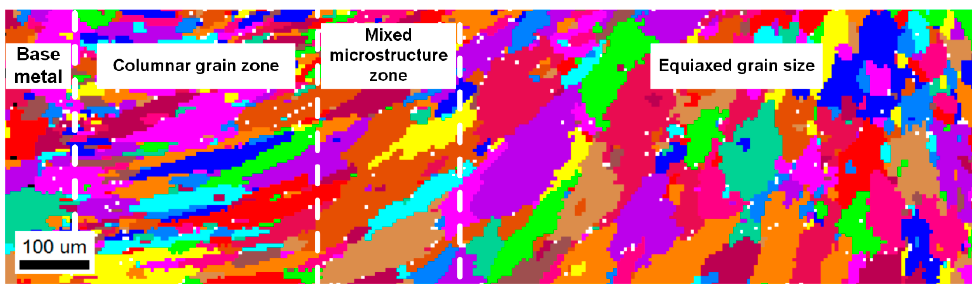
Figure 21. The microstructure of fusion zone. Metals 2020 , 10 , x